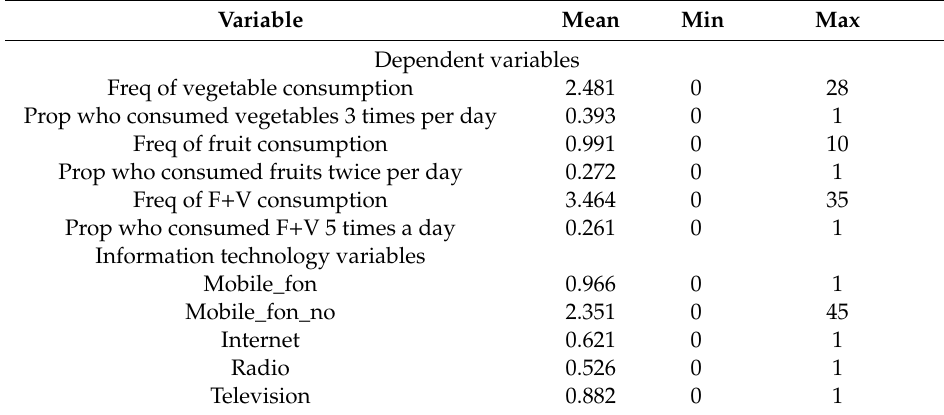
Table 2. Summary statistics of consumption and information access